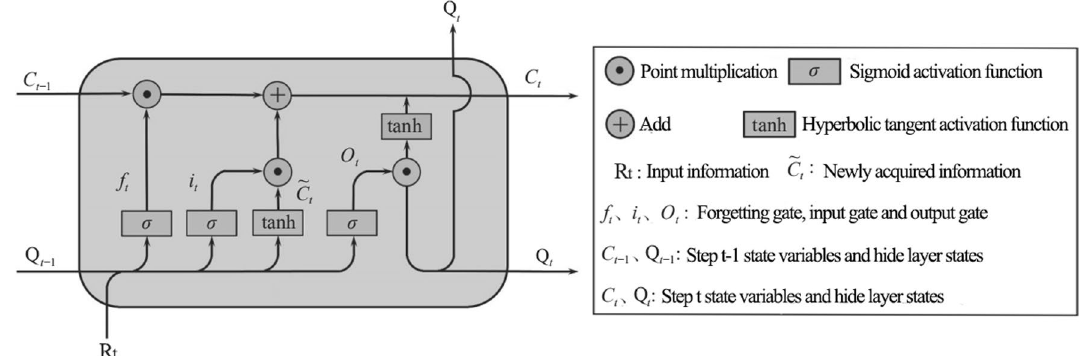
Fig. 4 Memory cell unit structure in the hidden layer of